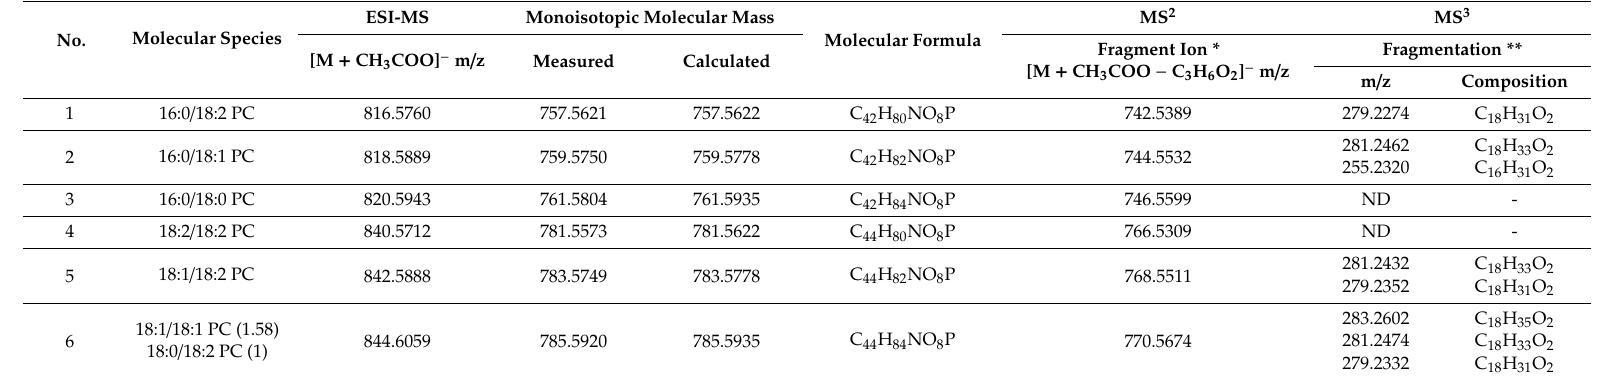
Table 4. Molecular species of phosphatidylcholine (PC) from Madhuca ellitica